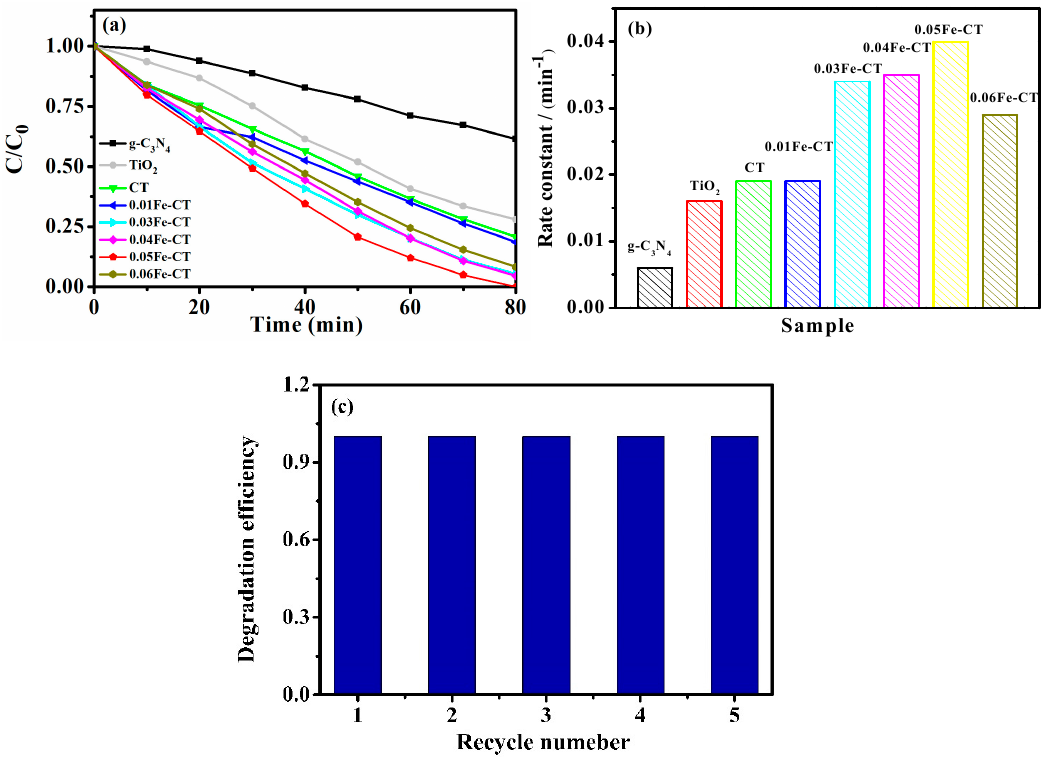
Figure 7. ( a ) Change of concentration of phenol during the photodegradation process; ( b ) the kinetic constants for all samples; ( c ) the cyclic test of 0.05Fe ‐ CT for its stability.